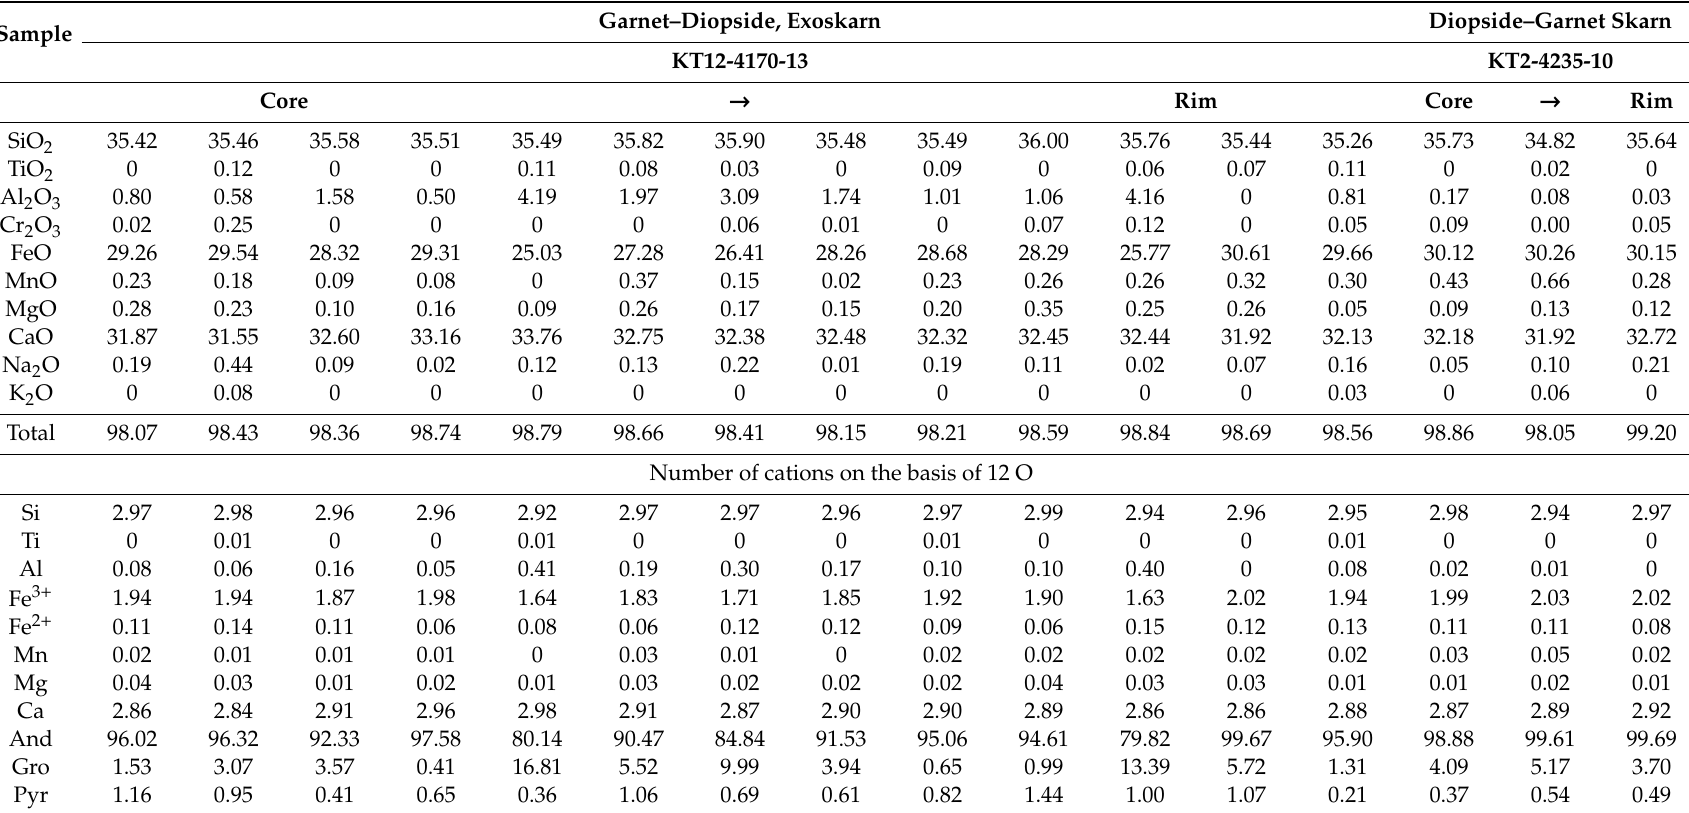
Table 2. Electron microprobe analyses of garnet from the Hongshan deposit (wt